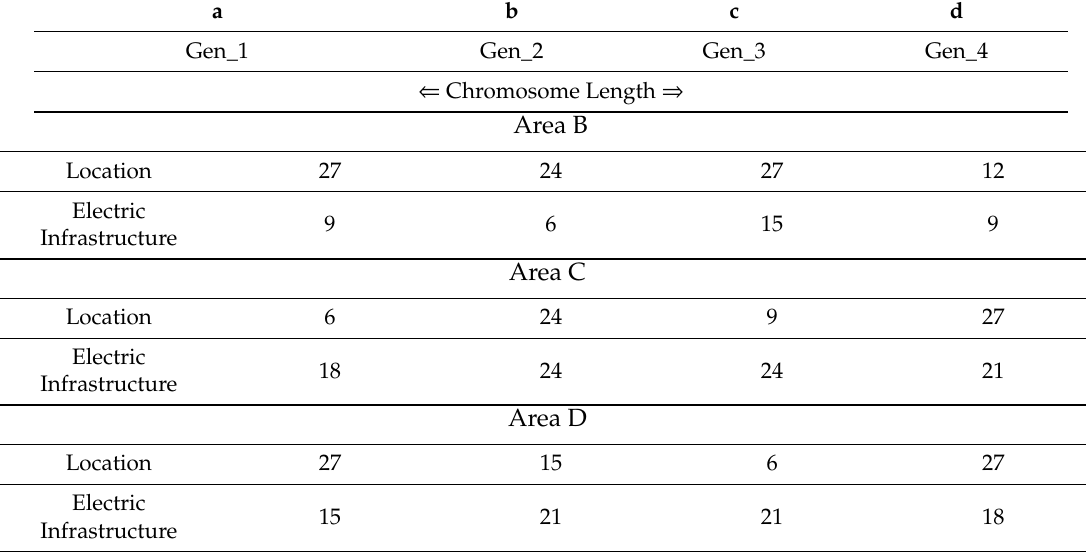
Table 3. Chromosome structure for aforementioned locations with their corresponding areas (termed as B, C, and D).